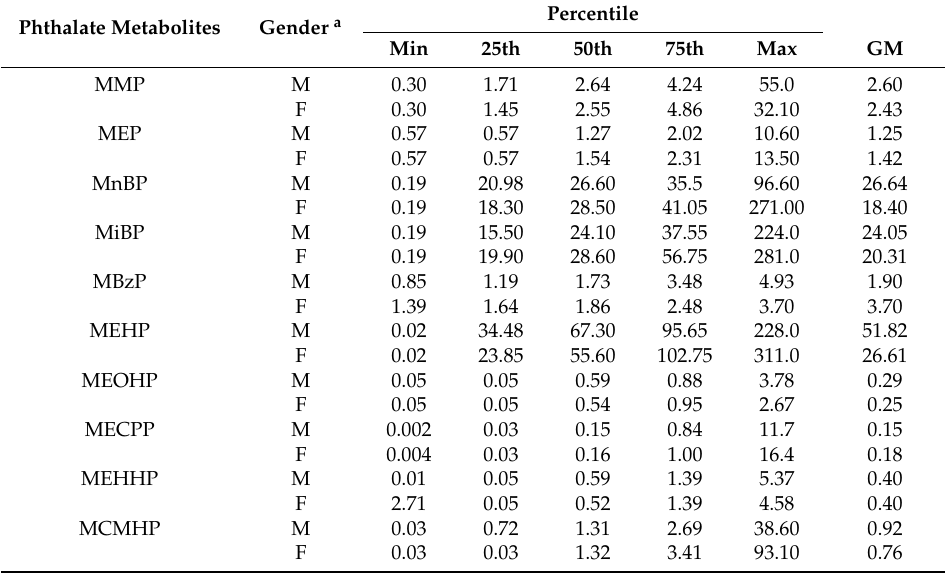
Table 3. The concentrations of phthalate metabolites in meconium of newborns ( n = 251, ng / g). Percentile Phthalate Metabolites Gender a Min